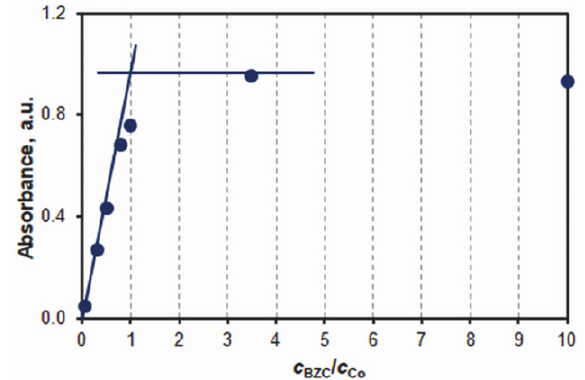
Figure 7. Determination of the BZC-to-Co molar ratio by the You and Jones method.